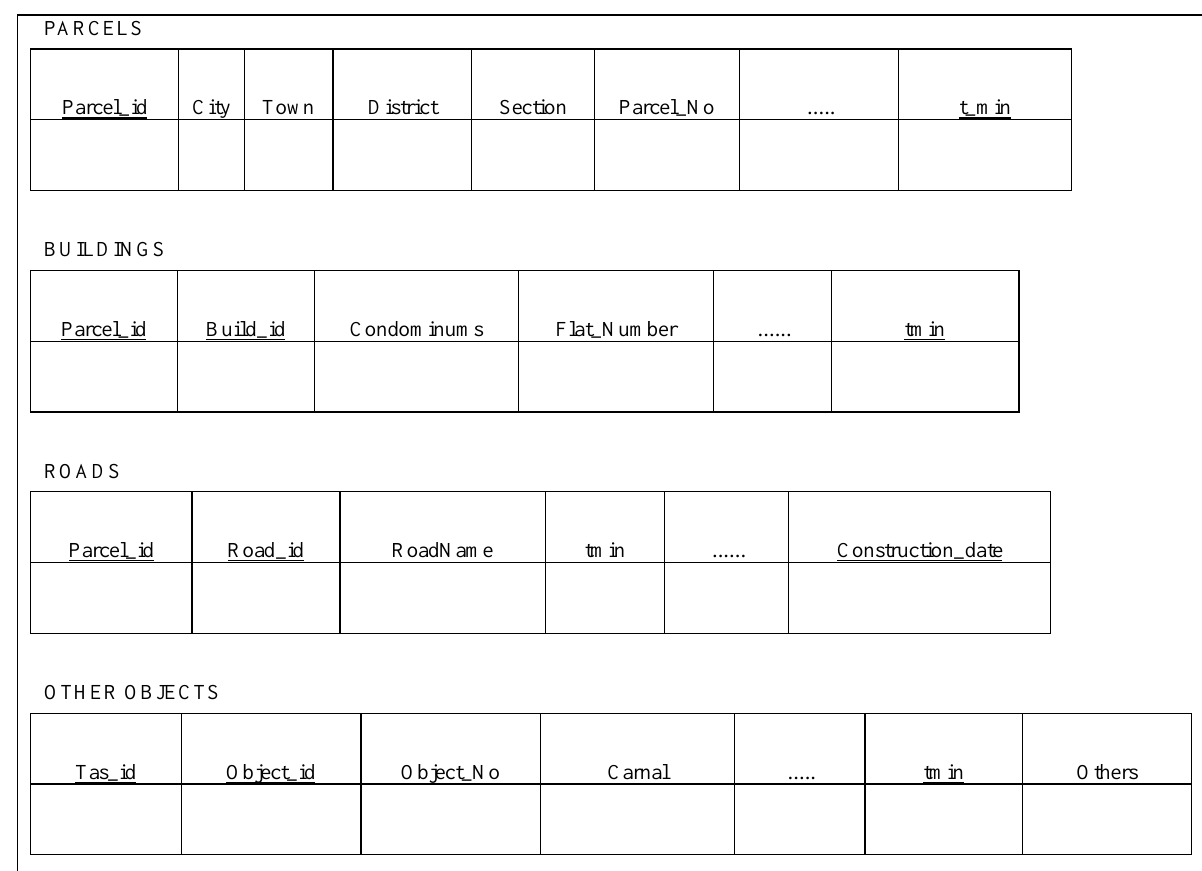
Figure 3. A portion of the database schema.